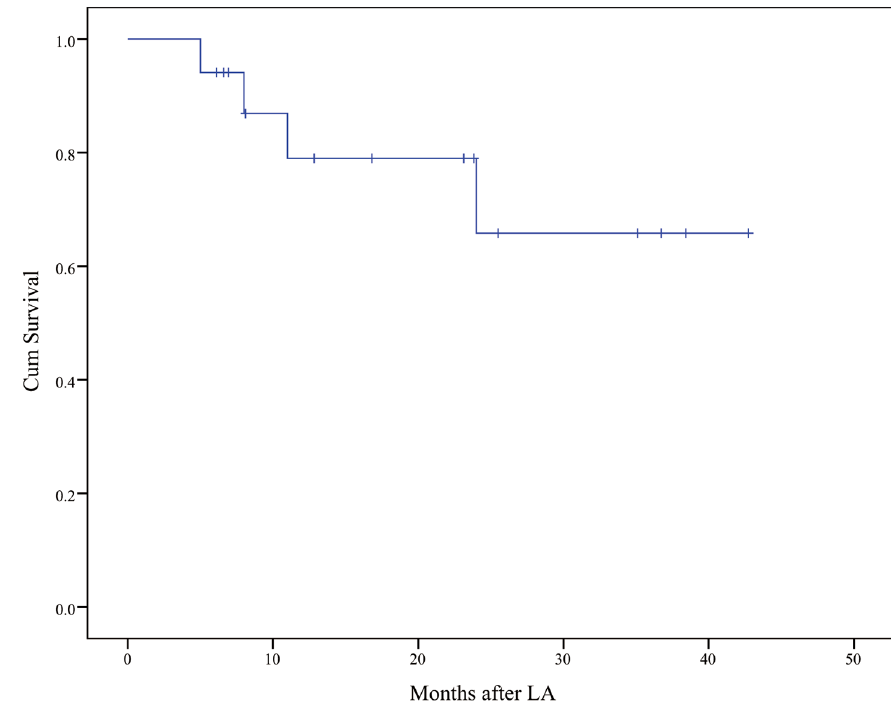
Figure 2. Overall survival after laser ablation for extrahepatic metastases. LA = laser